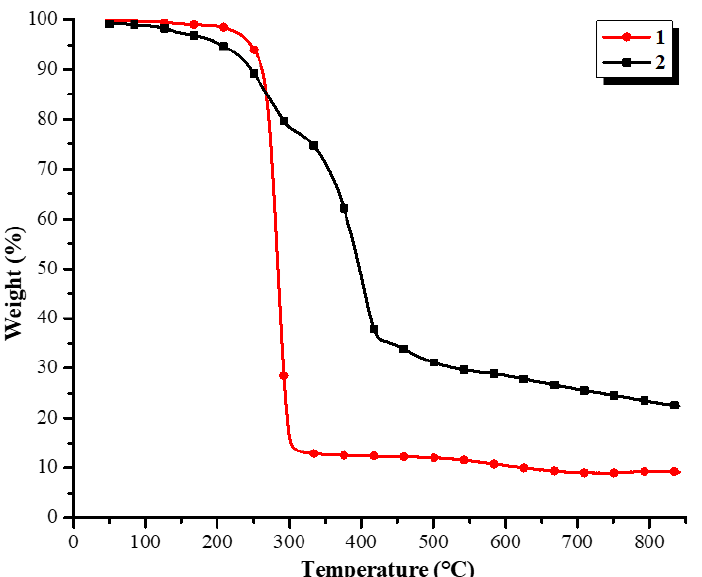
Figure 7. TGA curves of compounds 1 and 2 .